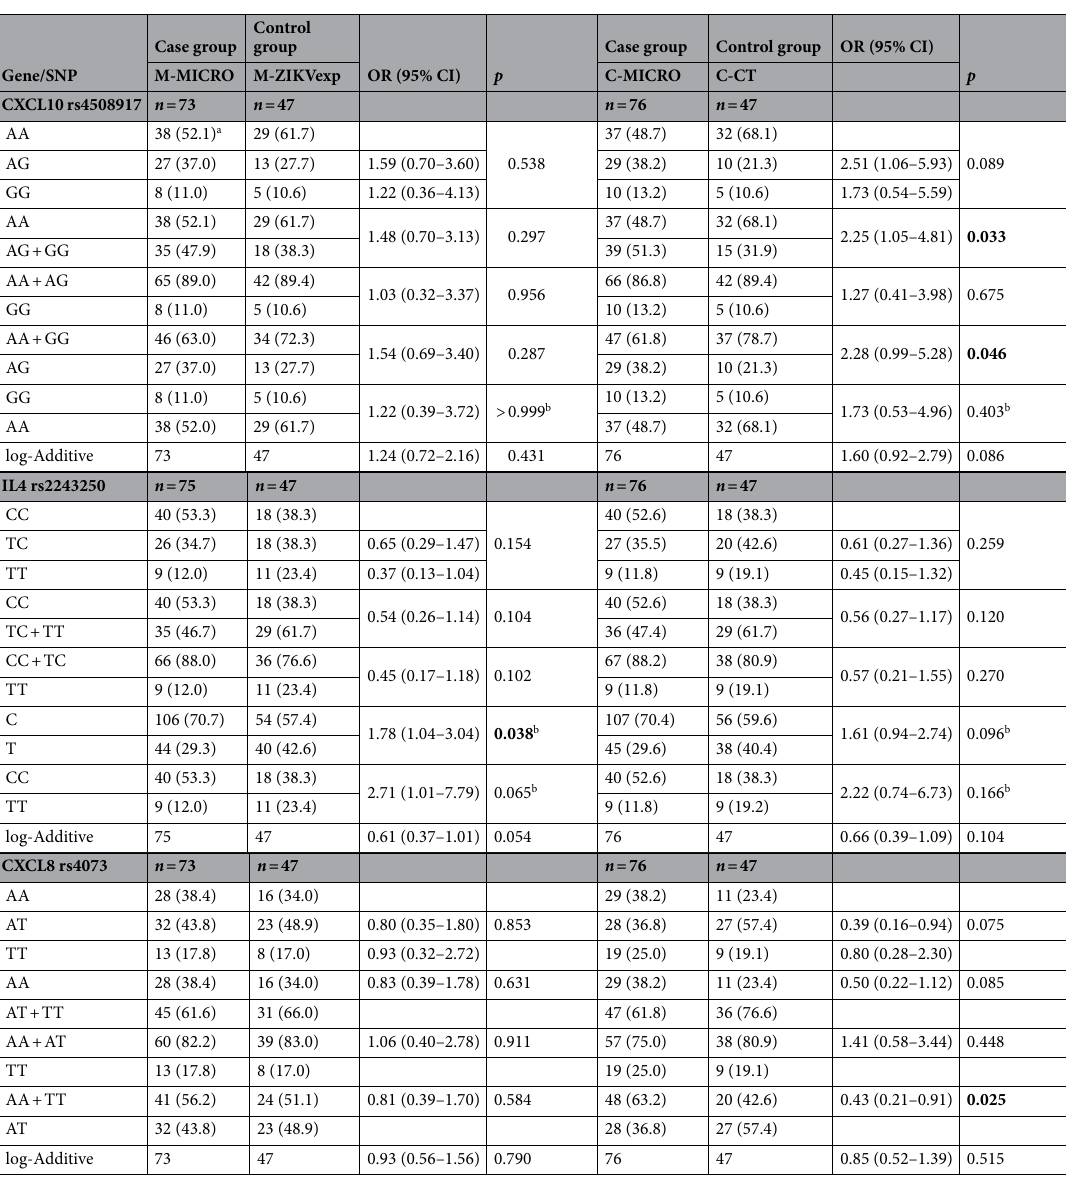
Table 4. Genotype and allelic frequency and distribution of CXCL10 rs4508917, IL4 rs2243250 and CXCL8 rs4073 SNP and their association with CZS. M-MICRO, women who gave birth to infants with